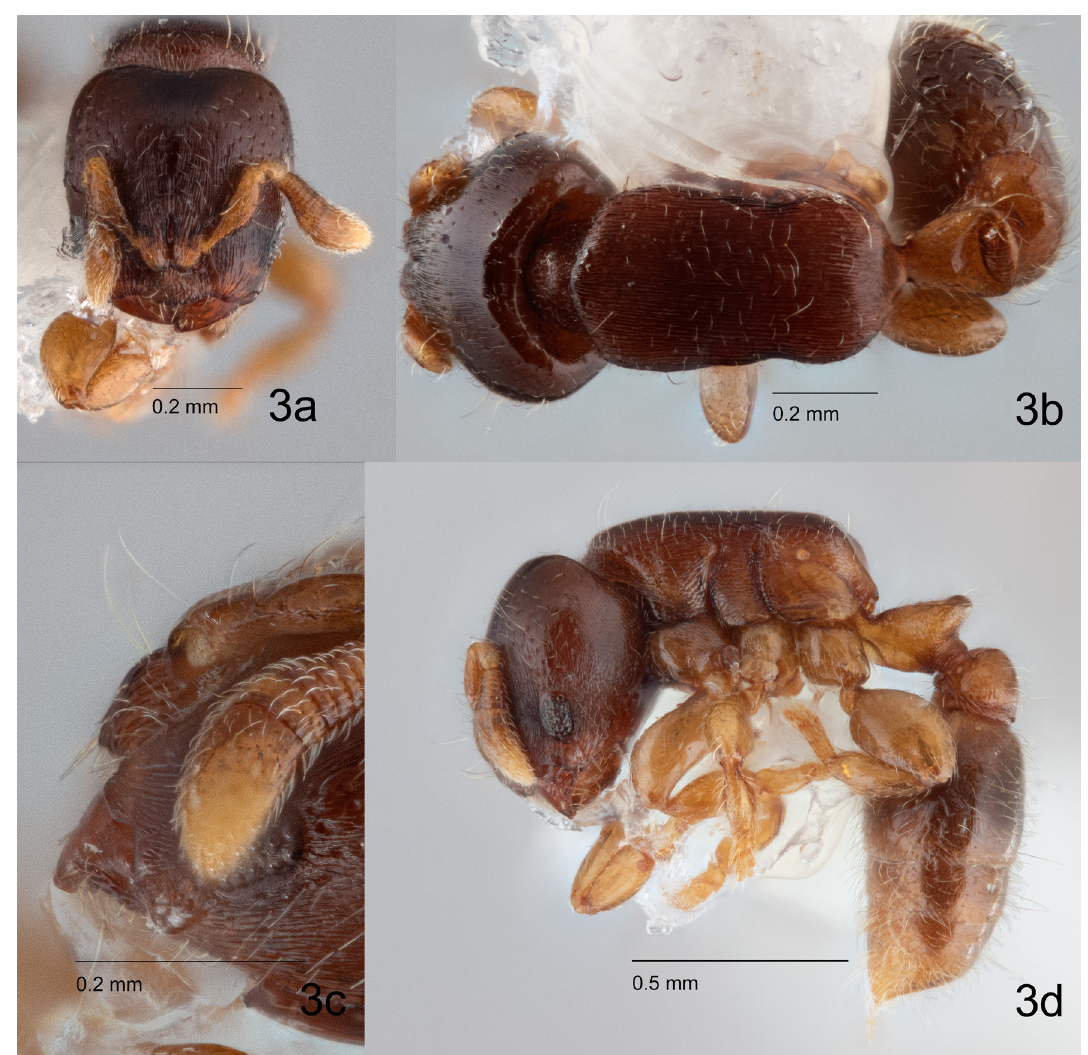
Fig. 3. Rhopalomastix impithuksai Wang & Jaitrong sp. nov., paratype, worker (ZRC_ENT00007608.1). a . Head in full face view. b . Mesosoma in dorsal view. c . Close-up of clypeus in profile. d . Body in lateral view. Note: anterior face of petiolar node near apex dented/slightly